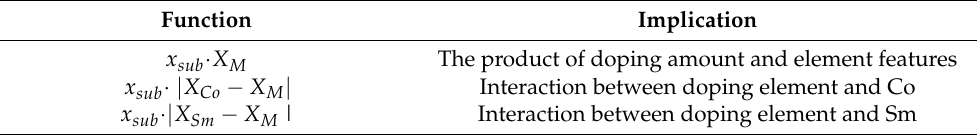
Table 2. New intrinsic feature constructor. Function